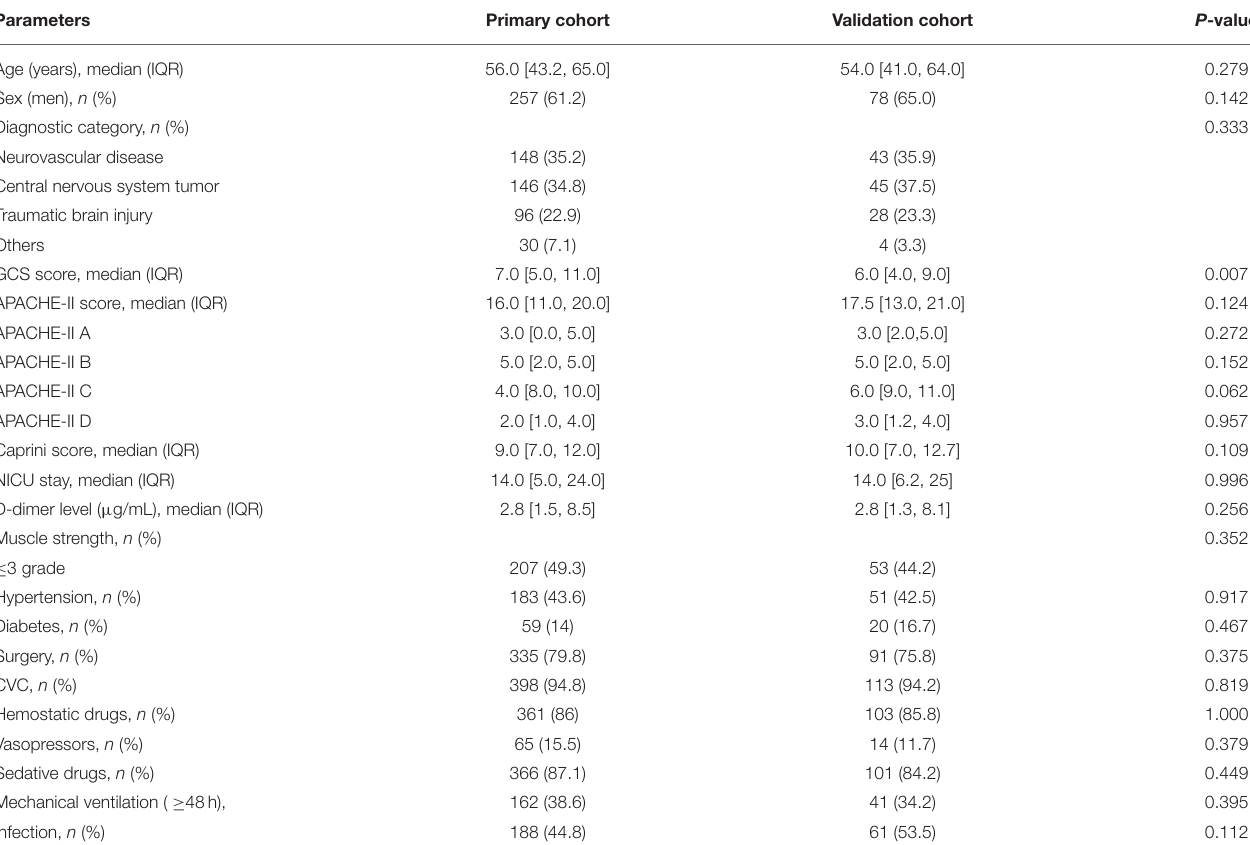
TABLE 1 | Baseline clinical and demographic characteristics of the primary and validation cohorts.